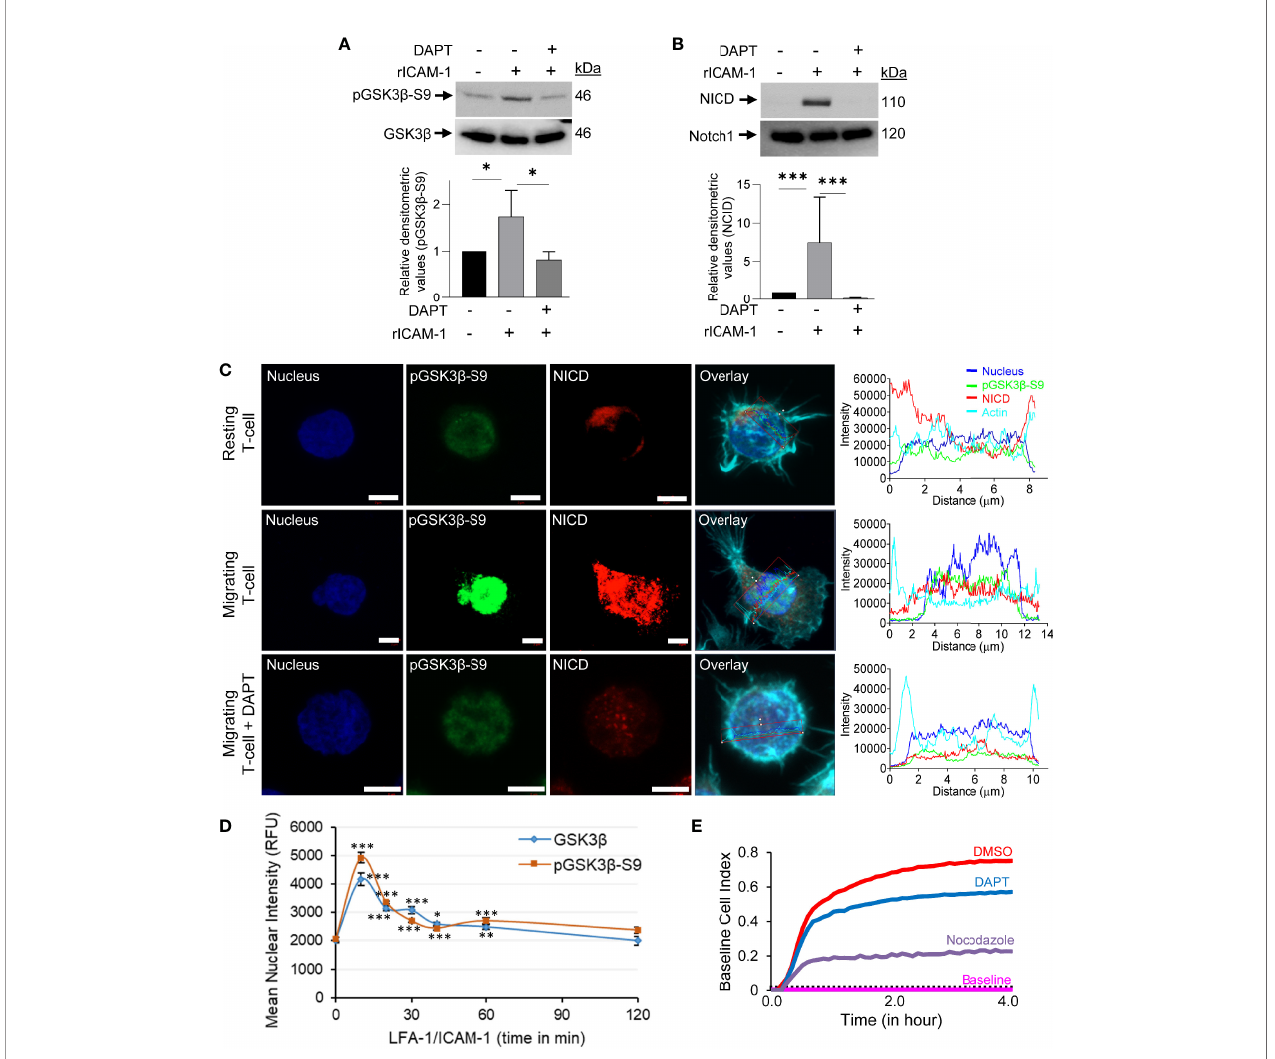
FIGURE 3 | GSK3 b -Notch1 interactions in motile T-cells. (A, B) Human primary T-cells, untreated or pre-treated with 10 m M DAPT, were stimulated to migrate on rICAM-1-coated plates for 30 min and lysed. Cellular lysates were Western immunoblotted for pGSK3 b -S9, GSK3 b , NICD and total Notch1. The expression levels of proteins were quanti fi ed by determining relative densitometry (mean ± SEM) of pGSK3 b -S9/GSK3 b and NICD/Notch1. (C) Resting and LFA-1-stimulated HuT78 T- cells were immunostained with anti-pGSK3 b -S9/Alexa Fluor ® 488 ( green ), anti-NICD/Alexa Fluor ® 568 ( red ), Phalloidin-Alexa Fluor ® 647 (actin, cyan ) and Hoechst (nucleus, blue ) and then imaged by confocal laser scanning microscopy, 63X oil objective. Overlay images with intensity pro fi les (replotted using the GraphPad Prism software) of nucleus, pGSK3 b -S9, NICD and actin are shown. Scale bar = 5 m m. (D) T-cells (2×10 4 cells/per well) were allowed to migrate on rICAM-1-coated 96- well plate for multiple time-points up to 2 h and fi xed. Cells were stained for pGSK3 b -S9 or GSK3 b and imaged by an automated IN Cell Analyzer 2200 microscope using 20X objective (6 fi elds/well). Cellular images containing >500 cells/well were subsequently analysed cell-by-cell by the IN Cell Investigator software. (E) HuT78 T-cells were pre-treated with 10 µM DAPT, nocodazole (positive control), or DMSO (solvent control) and then allowed to migrate on rICAM-1-coated E-Plate 16. Cell migration was recorded in real-time using impedance-based measurements by the RTCA instrument. Wells without cells were used to automatically draw